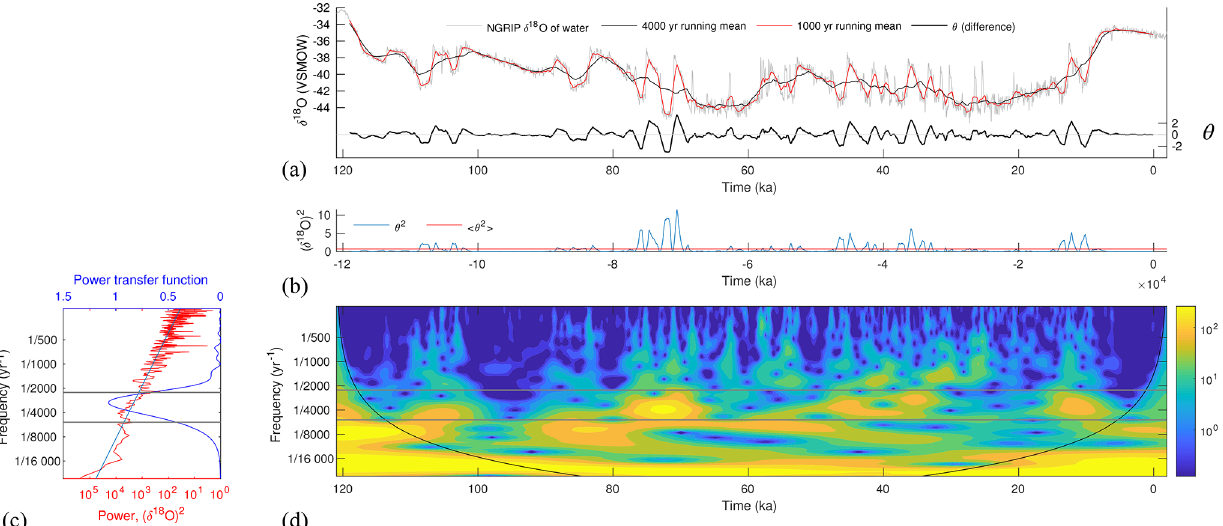
Figure 3. Temporal representativeness error in the time and frequency domains. Errors in representing a 4000-year mean by a 1000-year mean are estimated by computing the difference θ ( a , thick black line) between a 4000-year (red line) and 1000-year (thin black line) running mean of the NGRIP δ 18 O ice record (grey). The time average (red line, b ) of θ 2 (blue line) is an estimate (0.7(‰ δ 18 O) 2 ) of the temporal representativeness error variance. Large values in θ 2 correspond to time periods with increased variability, as diagnosed by a wavelet analysis (d) , particularly in the band between 2257- and 5298-year periods (grey lines). Panel (c) shows the power transfer function H (dark blue line), the NGRIP spectrum (red line), and the power spectrum ν − β with β = 1 . 53 derived by a least-squares fit to the NGRIP